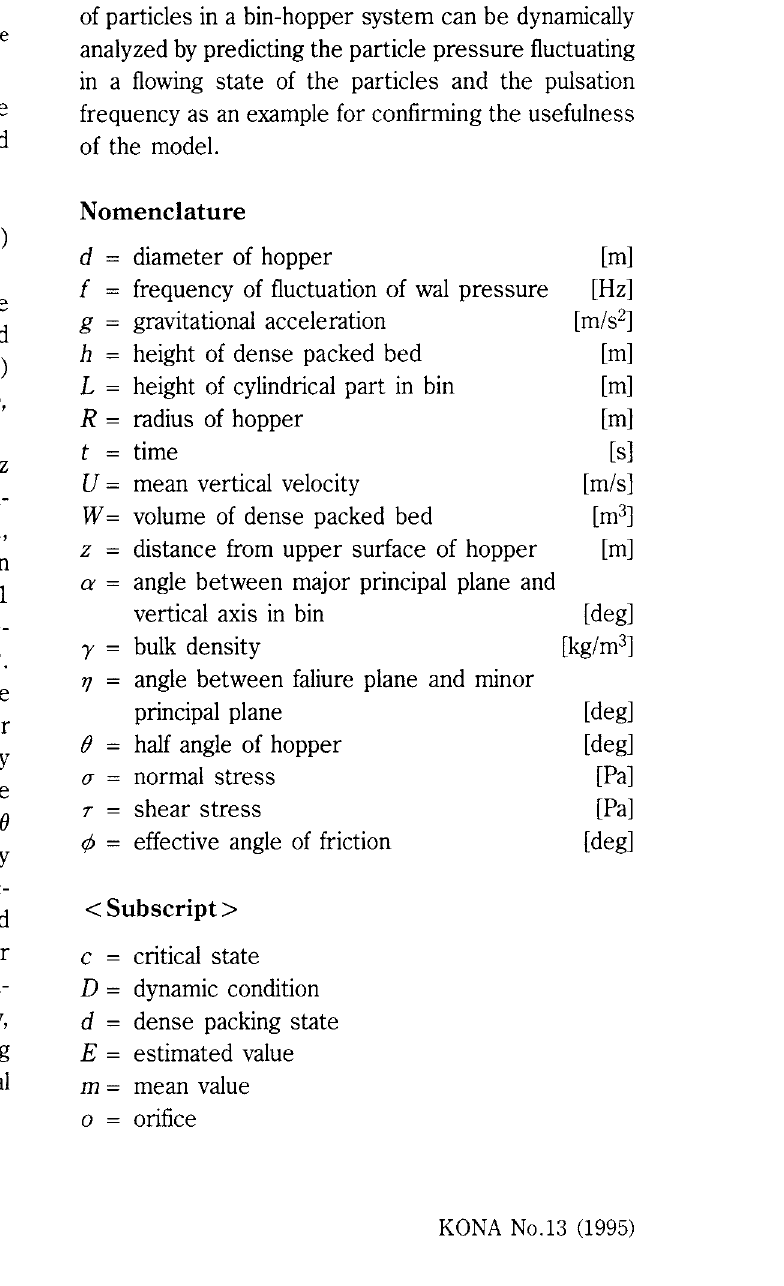
Fig. 8 Calculated slip line and waveforms of dynamic pressure acting on hopper